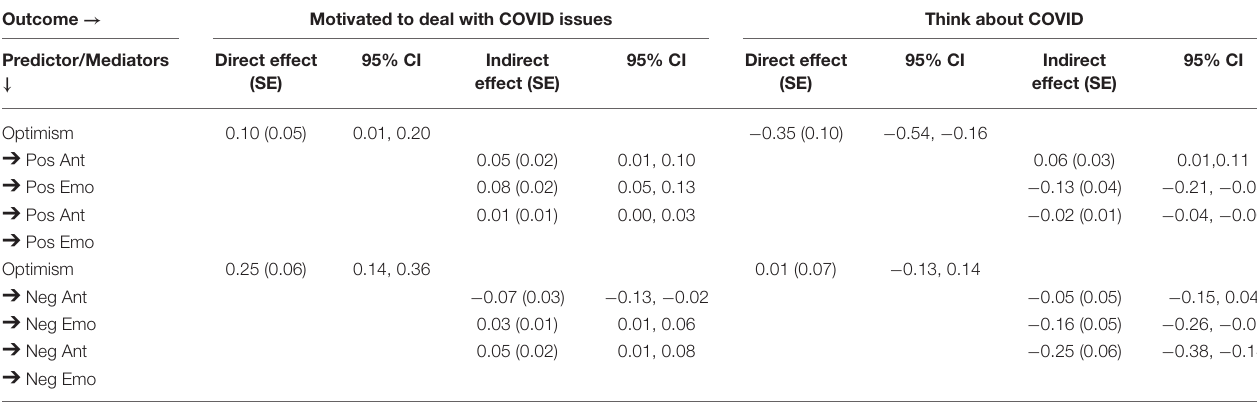
TABLE 2 | Mediational models with optimism predicting emotions through anticipation. Outcome → Motivated to deal with COVID issues